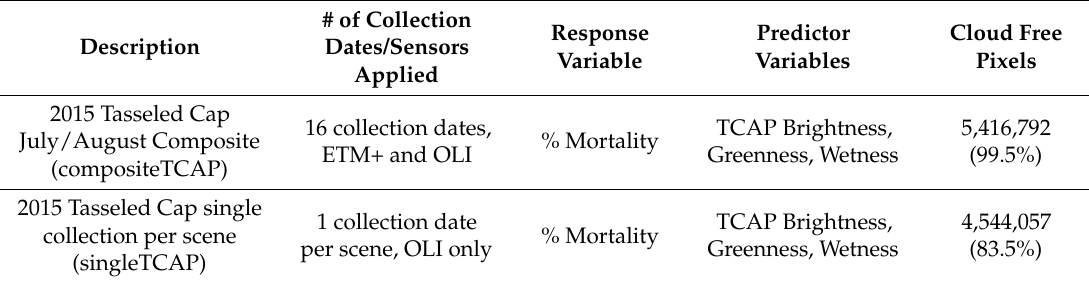
Table 2. Characteristics of the two predictive layer stacks that were used in the initial comparison of composited predictors versus single image date predictors and the number of cloud free pixels remaining in each product following the two processing